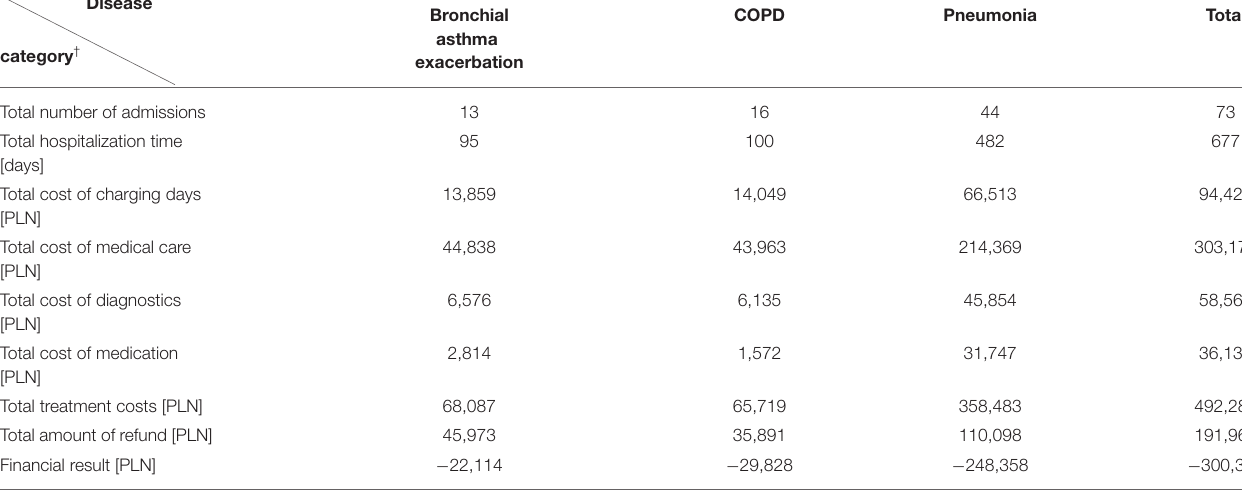
TABLE 3 | Financing costs of selected health effects of air pollution,